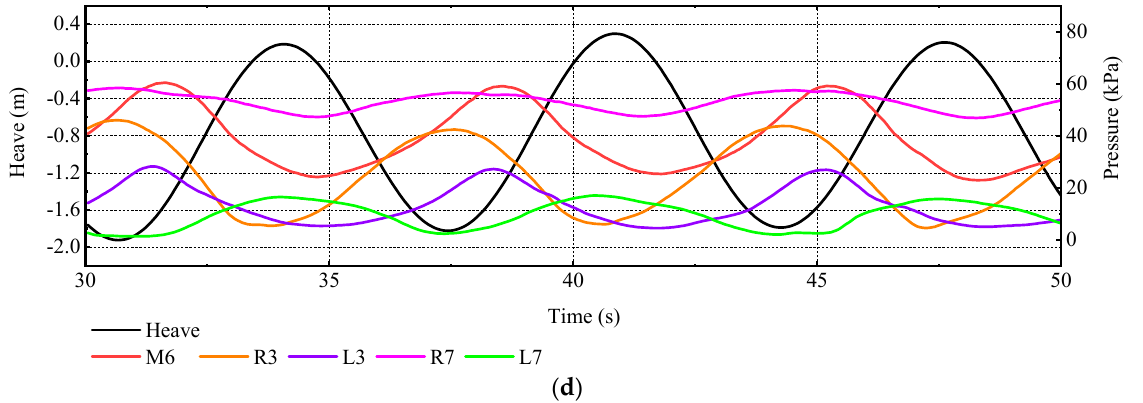
Figure 18. Time histories of motion and slamming pressure. ( a ) Roll, pitch and slamming pressure ( θ = 45°); ( b ) Roll, pitch and slamming pressure ( θ = 135°); ( c ) Heave and slamming pressure ( θ = 45°); ( d ) Heave and slamming pressure ( θ = 135°).